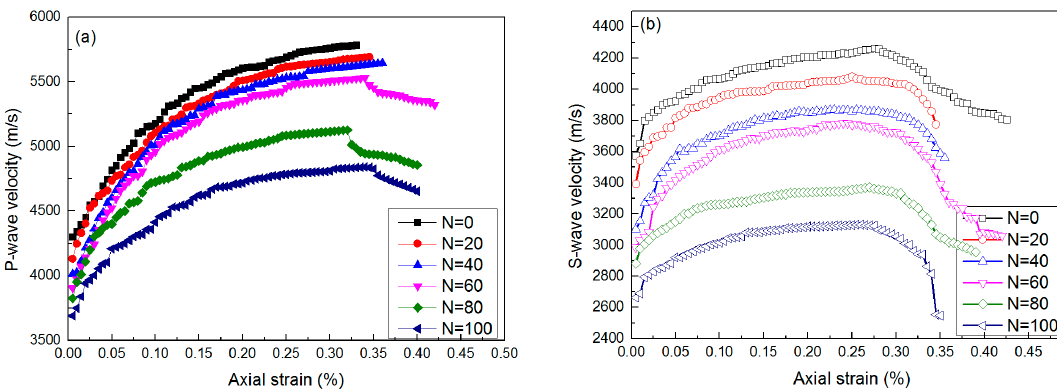
Figure 14. Comparison of P and S-wave velocity during the whole deformation for granite samples subjected to different F–T cycles. ( a ) Relationship between the P-wave velocity and axial strain; ( b ) relationship between the S-wave velocity and axial strain.